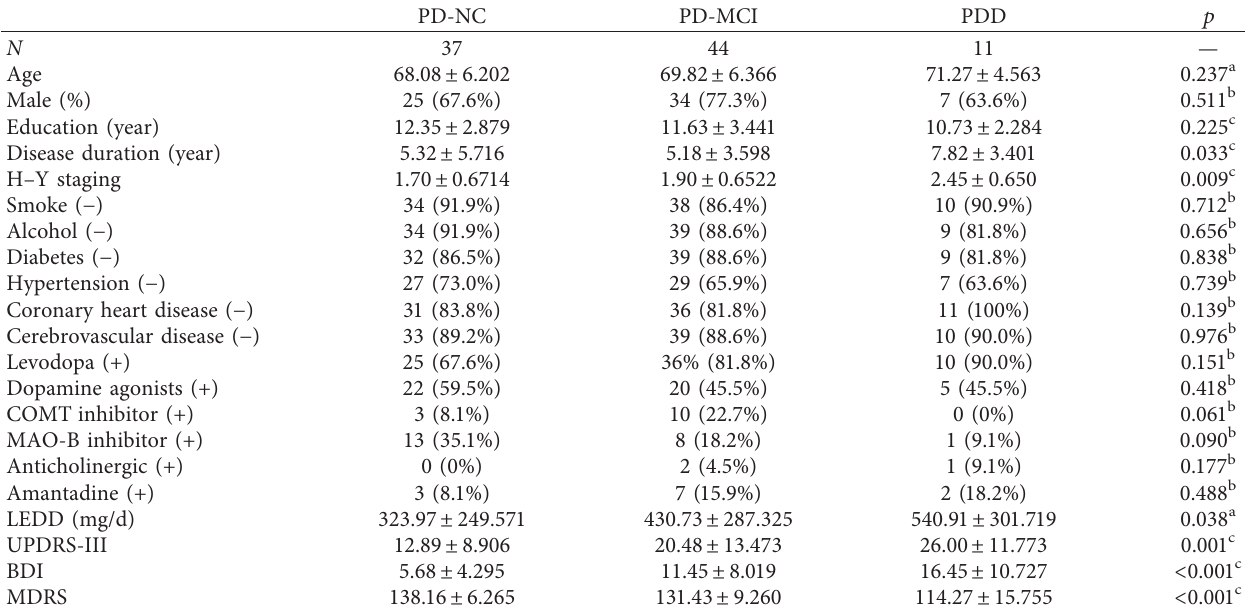
Table 1: Demographic and clinical characteristics between PD-NC, PD-MCI, and PDD